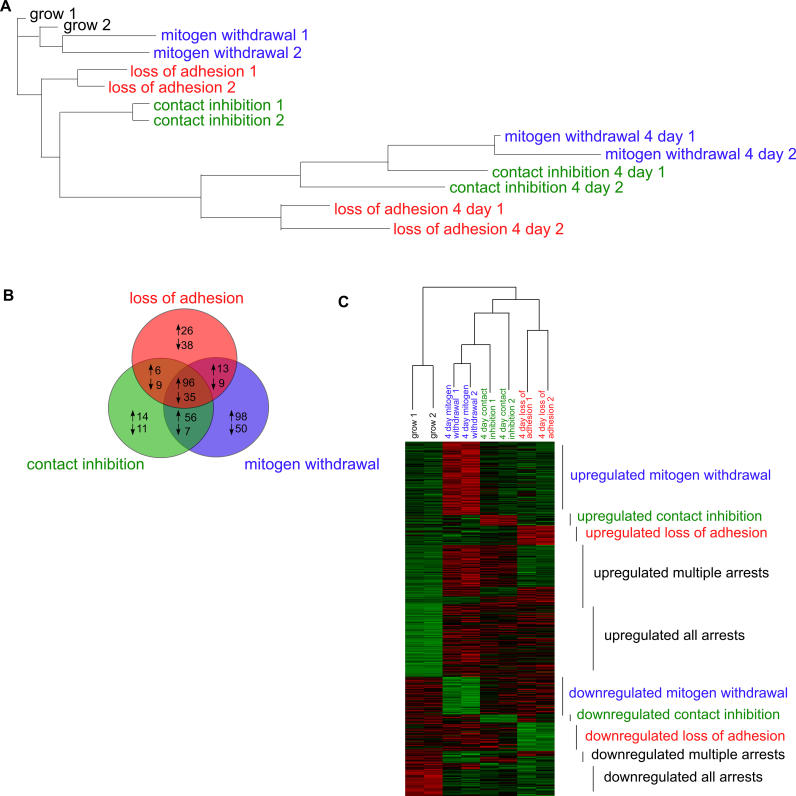
Quiescence Maintenance(A) Neighbor-joining tree of quiescence initiation and maintenance. Neighbor-joining tree of the transcriptional distance between samples after overnight and 4 d of quiescence generated as described in Figure 2A.(B) Venn diagrams depicting the number of genes regulated by one, two, or three arrest signals during quiescence maintenance. Methods are as described in (Figure 2B), except that cells were arrested for 4 d. The number of genes downregulated specifically by mitogen withdrawal or by loss of adhesion was significantly greater than the expectation (7.8 genes) at p < 0.001. The number of genes downregulated by contact inhibition was not statistically significant. The expected number of genes upregulated by a single signal was 5.1, and the signature for genes upregulated by each of the signals individually was statistically significant (p < 0.001). The expected number of genes downregulated by two signals was one, and the observed values for all three combinations were significant at p < 0.001. The expected number of genes downregulated by all three arrest signals was 0.85, and the observed value of 33 was highly significant (p < 0.001). All combinations of upregulation by two signals were statistically significantly elevated (p < 0.001) as compared with the expectation of 0.75 genes. The number of genes expected to be upregulated by all three signals was 1.2, and the observed value of 96 was significantly different (p < 0.001).(C) “Heat maps” of genes regulated during quiescence maintenance. “Heat map” of the genes regulated after 4 d of quiescence and dendrogram are as described in Figure 2C.